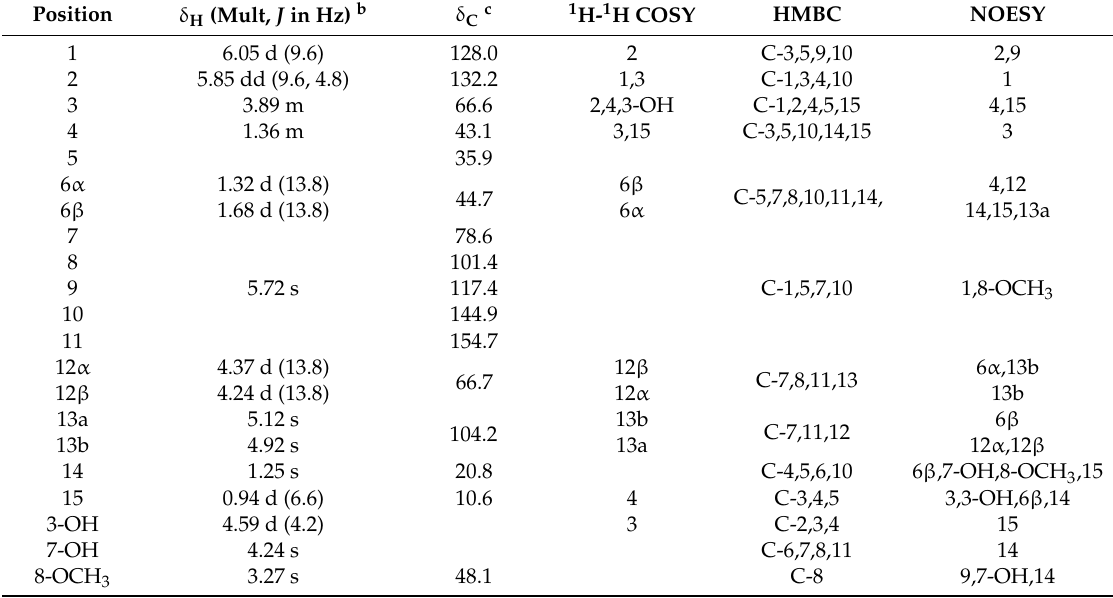
Figure 5. Comparison of the experimental ECD spectrum of 2 (black) with those calculated for the enantiomers 3 S 4 R 5 R 7 R 8 S (red) and 3 R 4 S 5 S 7 S 8 R (blue). (UV correction = 13 nm, bandwidth σ = 0.3 eV). Table 2. NMR spectroscopic data for compound 2 (DMSO- d 6 ) a .